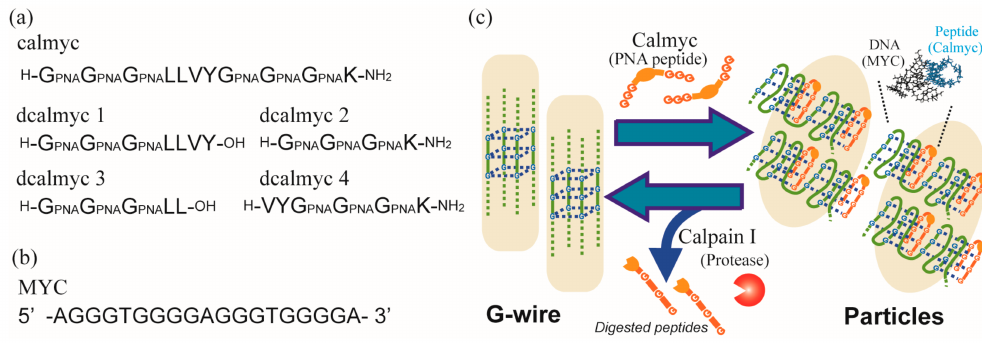
Figure 1. ( a ) Sequences of the designed peptides used in this study; ( b ) Sequence of the DNA used in this study; ( c ) Scheme showing switching of DNA nanostructures with changes of DNA secondary structures by the designed peptide, calmyc, and a specific protease, calpain